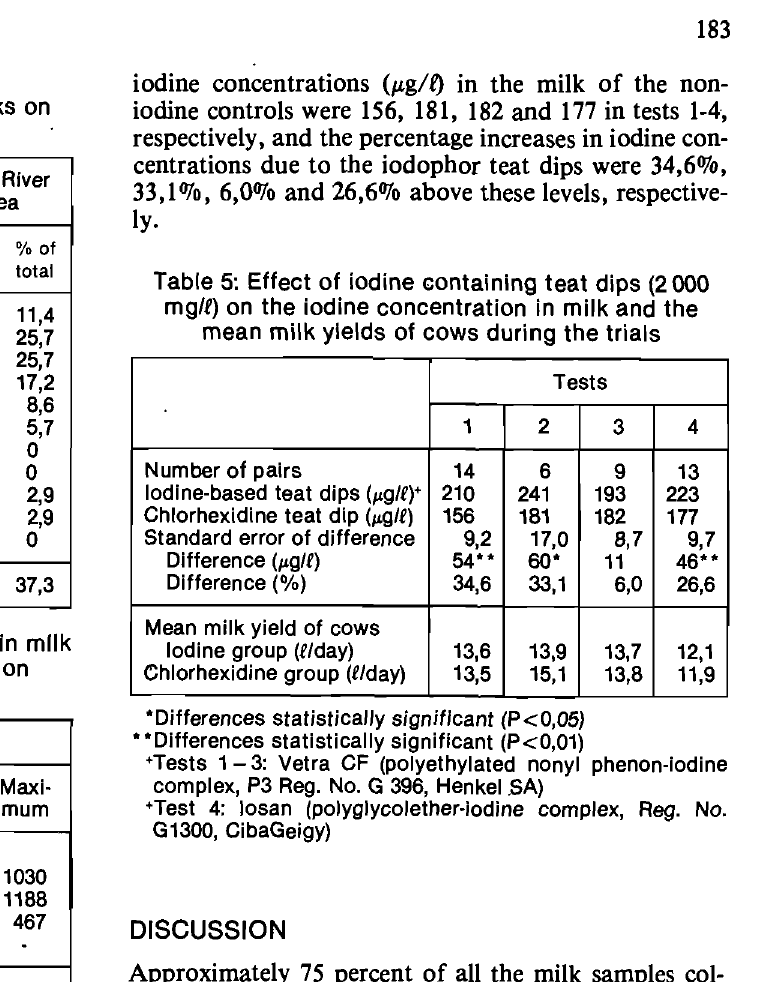
Samples from individual farm tanks